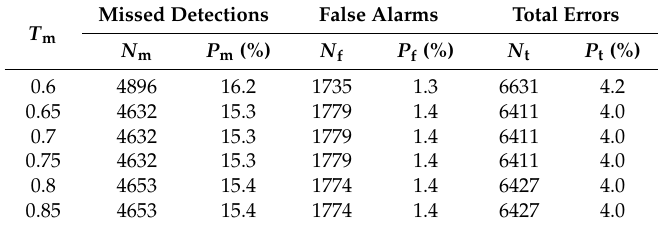
Table 2. Accuracy of CD results for different thresholds of data set 1.